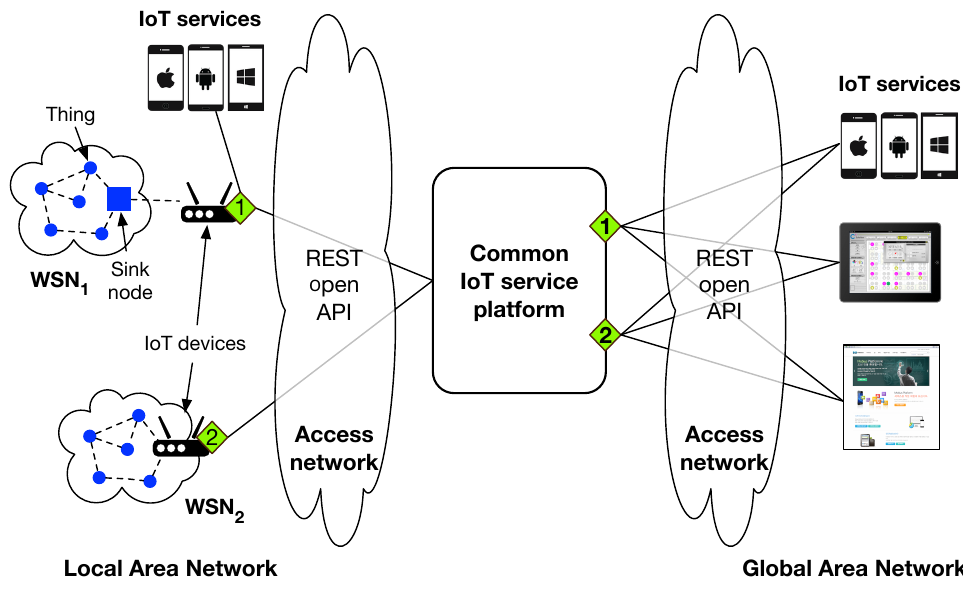
Figure 1. Requirements of providing the common IoT service platform and REST open API to make it easy to integrate legacy (marked as WSN 1 ) and new (marked as WSN 2 ) WSN-based systems into other IoT systems for building IoT application